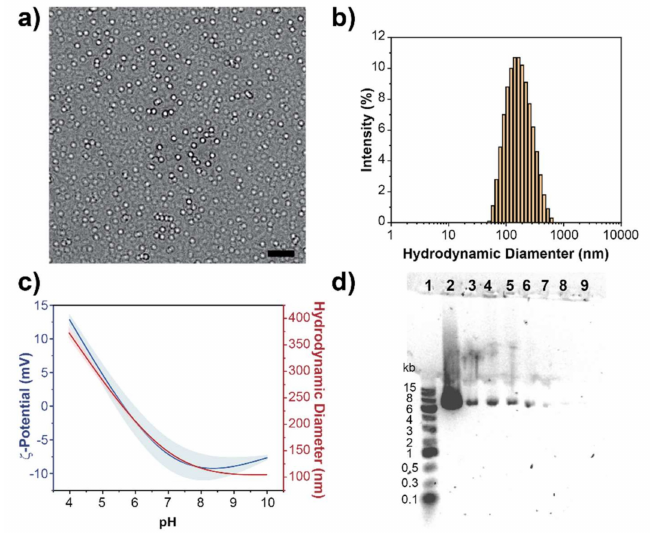
Figure 2. Poly (ethylene glycol)–block–poly(1,4-butanediol)–diacrylate- β ,–hydroxyamylamine– block–poly(ethylene glycol) (PEG-PDHA) nanoparticles (NPs) characterization. ( a ) Transmission electron microscopy (TEM) image of PEG-PDHA NPs, scale bar = 500 nm. ( b ) Hydrodynamic size distribution of PEG-PDHA NPs in PBS. ( c ) PEG-PDHA NPs ζ -potential and hydrodynamic diameter as a function of pH. Solid lines indicate mean value and shadows indicate standard deviation. ( d ) Gel Electrophoresis PEG-PDHA NPs encapsulating PBCAG at different molar ratios. Well 1: 1 kb Plus DNA ladder, Well 2: PBCAG (6.34 kb), Well 3–9: Polymer/plasmid at molar ratios of 18, 9, 3.6, 1.8, 0.9, 0.36 and 0.18,